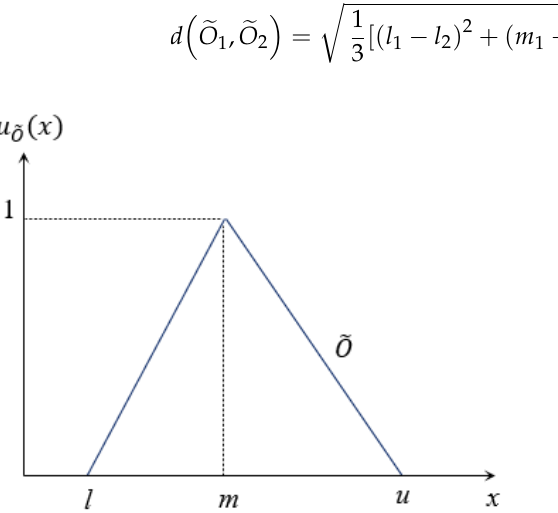
Figure 1. The membership function of a triangular fuzzy number Õ = ( l , m , u ).